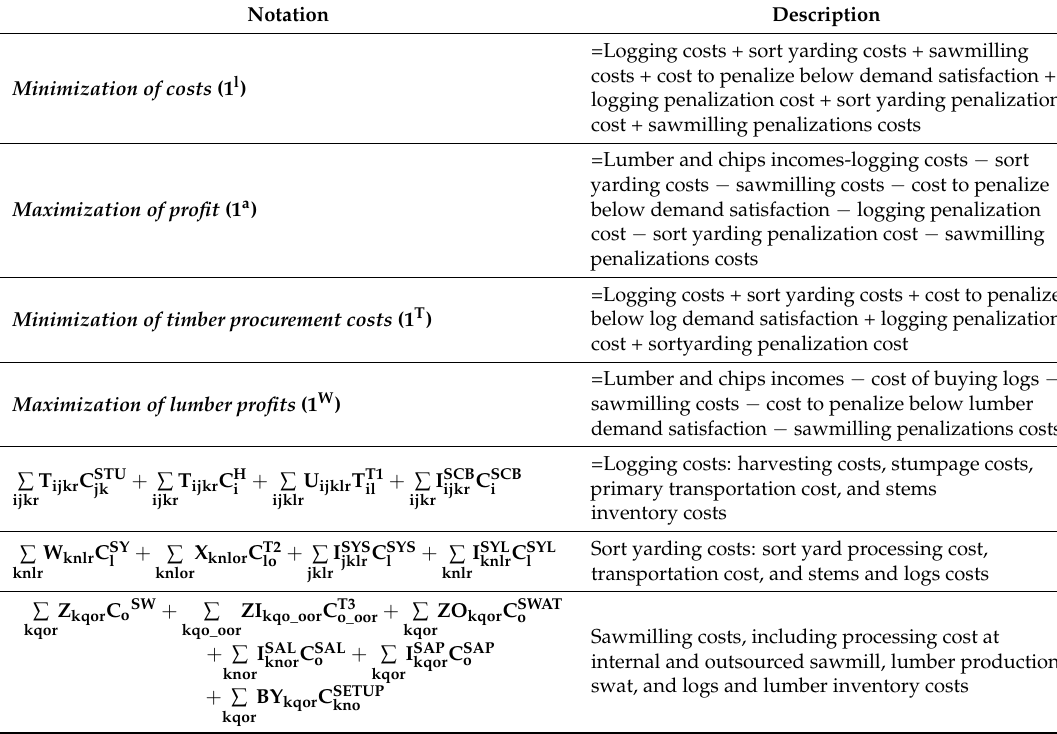
Table A6. Objective